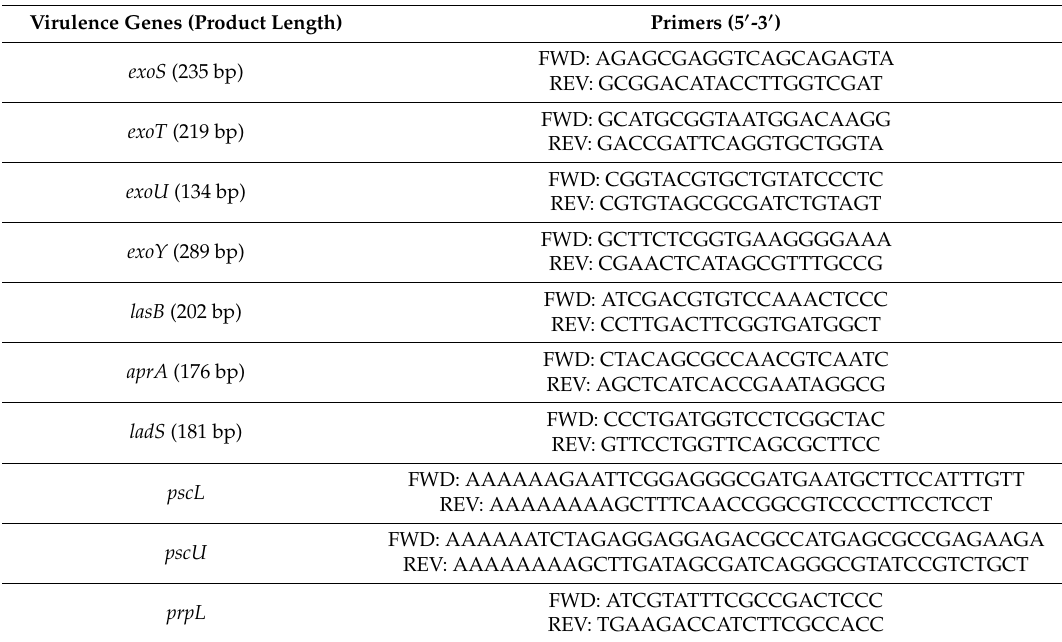
Table 1. Sequences of primers used for gene